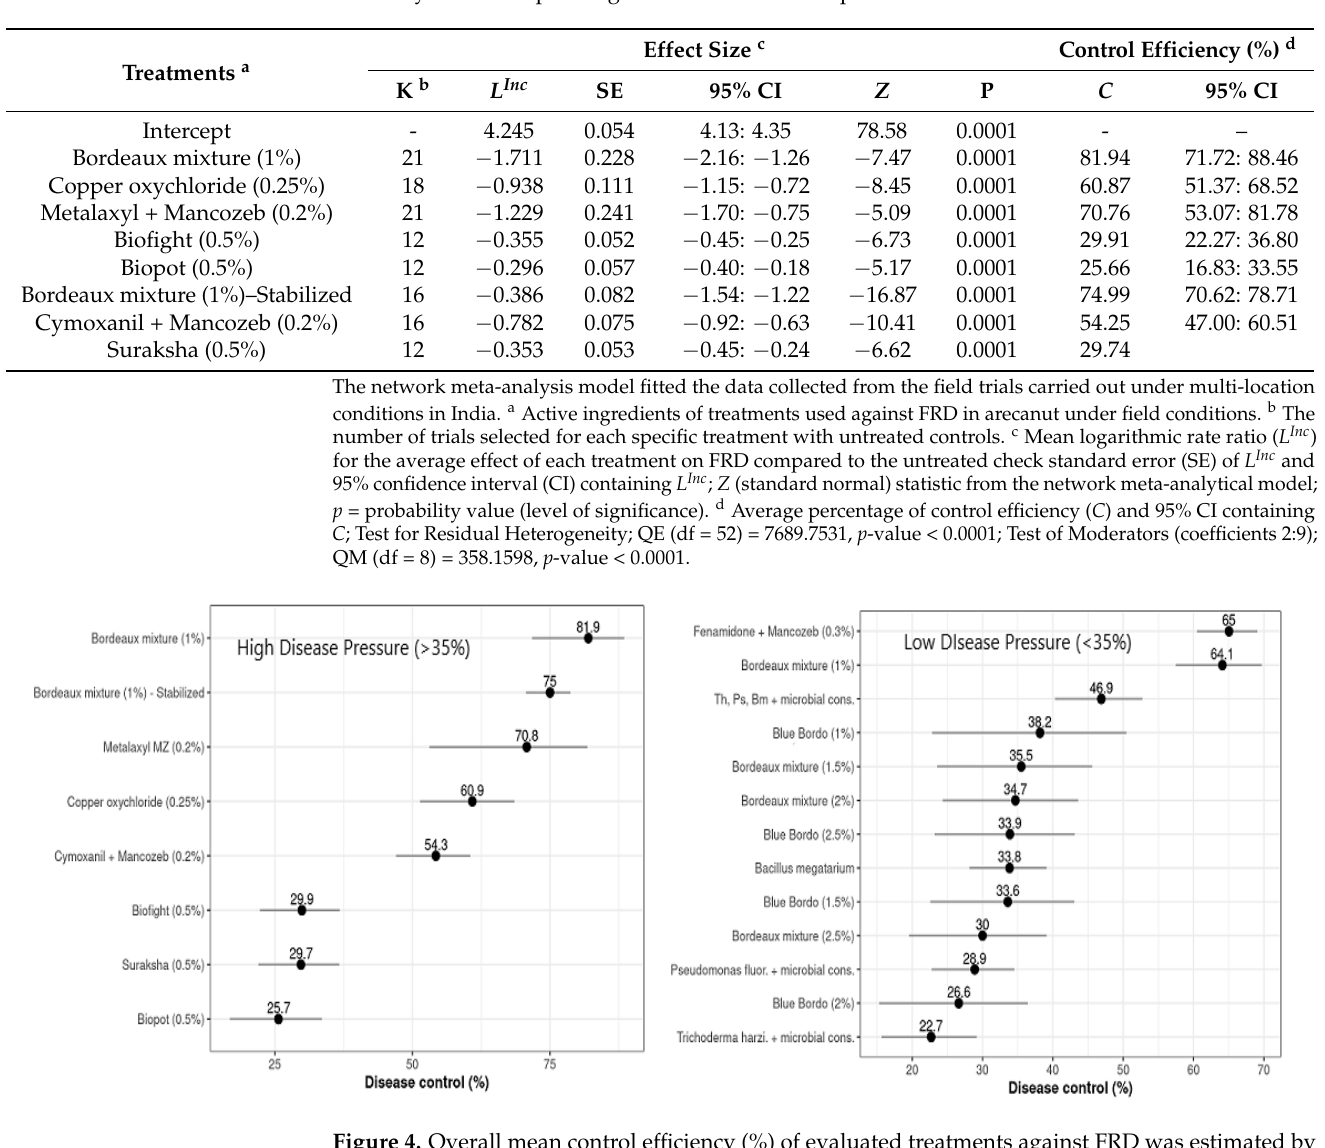
Table 3. Estimated response rate for FRD ( DP High > 35%) for each treatment compared to the untreated check, as determined via the network meta-analytical model. Percentages of control efficiency and corresponding model statistics are represented.